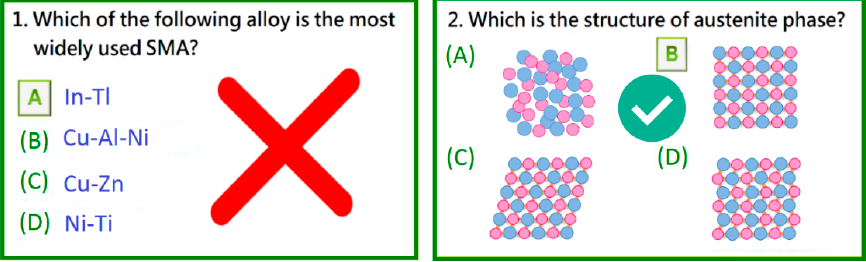
Figure 15. System response after answering the questions.